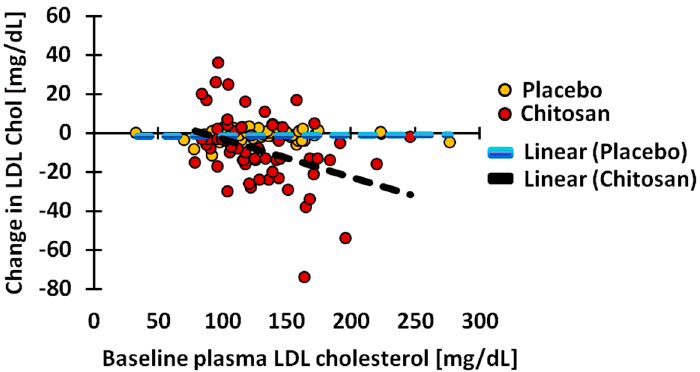
Figure 2. Dependence of change of serum low density lipoprotein (LDL) cholesterol concentration on baseline values under chitosan and placebo treatment. Under chitosan treatment, the change is significantly ( p = 0.0014) and negatively associated with the baseline value.